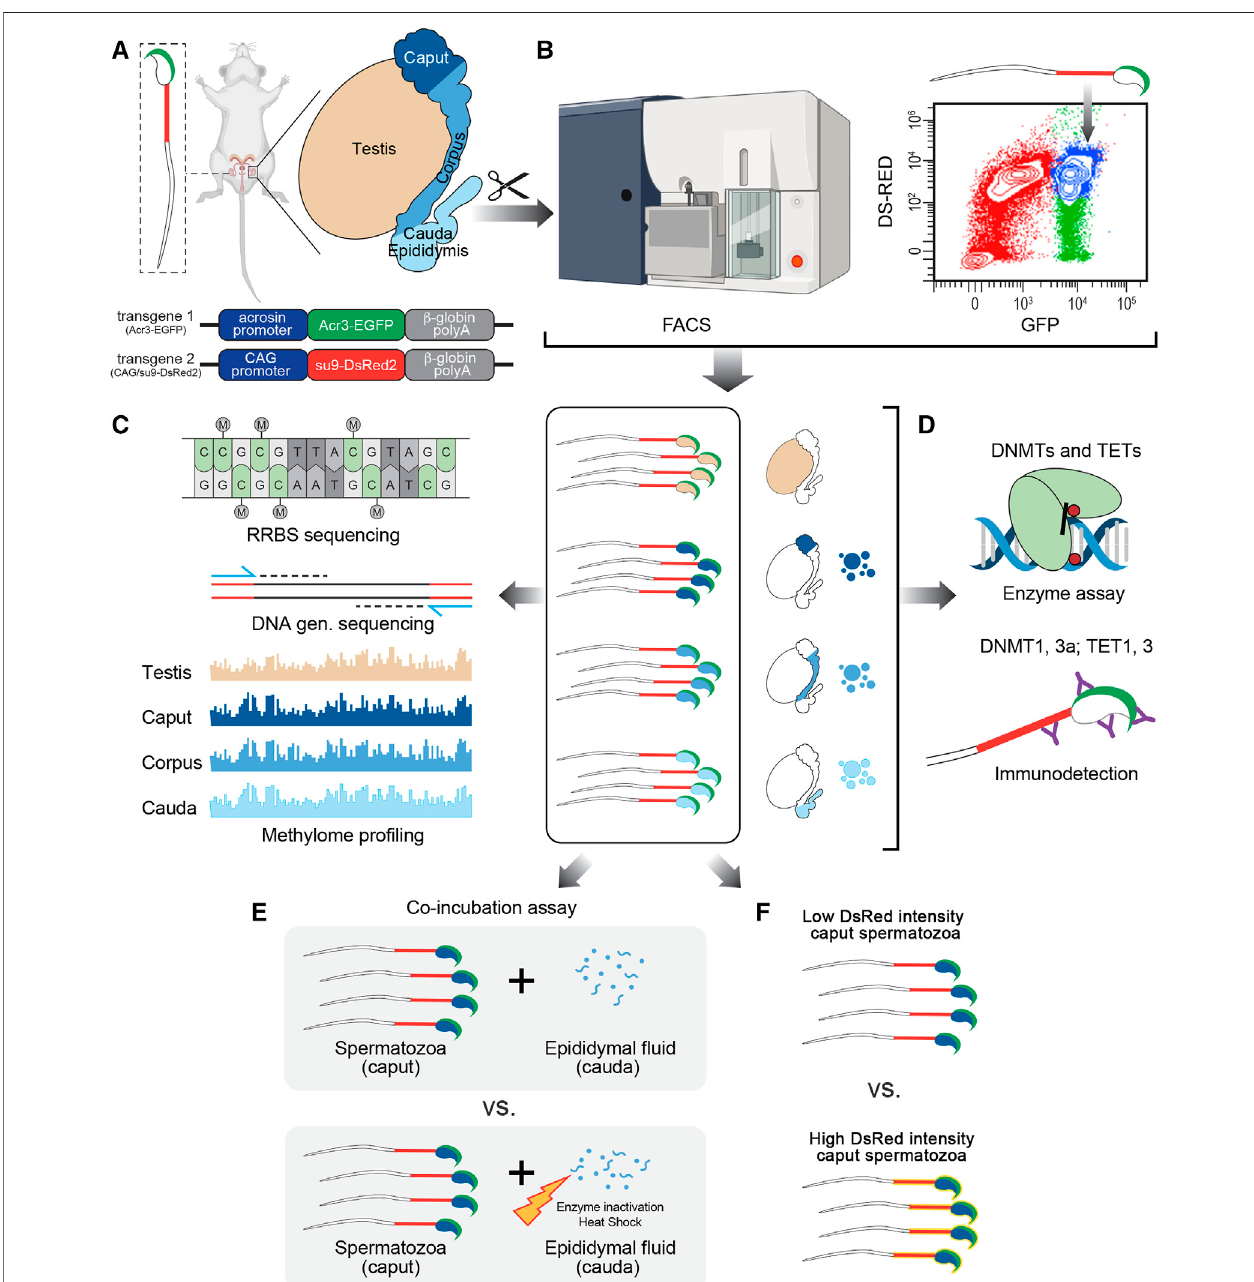
FIGURE 1 | Experimental design followed in this study. (A) Male reproductive system was collected from CAG/su9-DsRed2, Acr3-EGFP transgenic mice and dissected into regions corresponding to the testis, caput , corpus , and cauda epididymidis. (B) Spermatozoa were isolated from each region by fl